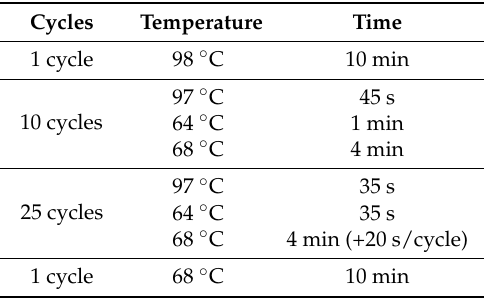
Table 1. PCR thermal cycling conditions for standard fragile X assay.